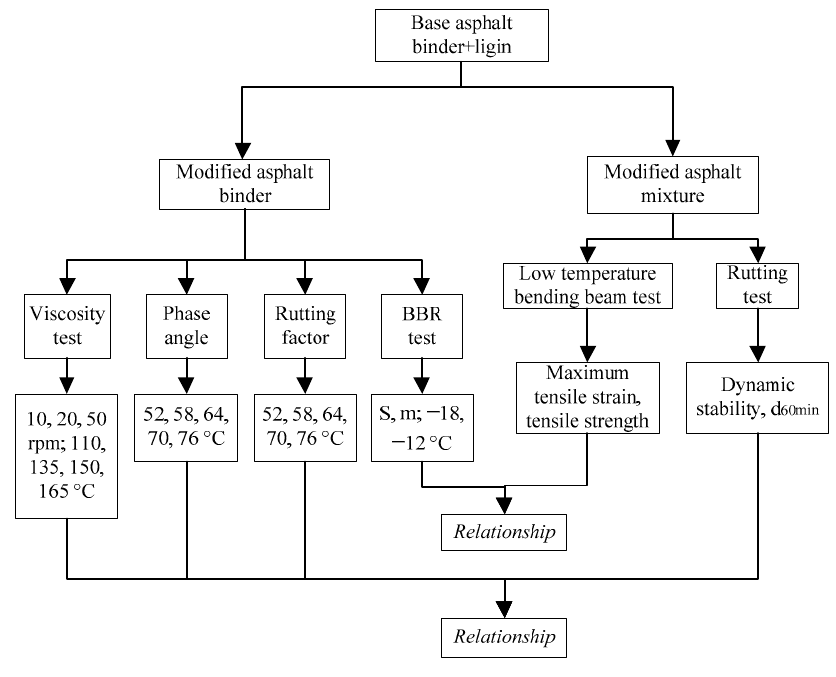
Figure 1. The map of this study.